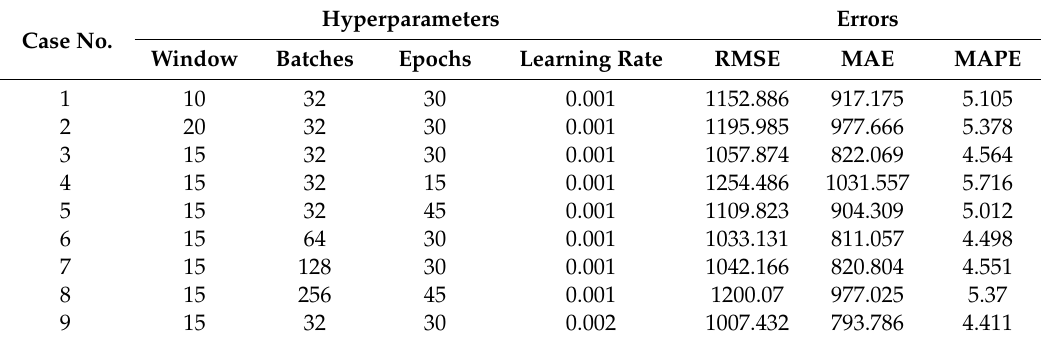
Table 7. Hyperparameters of